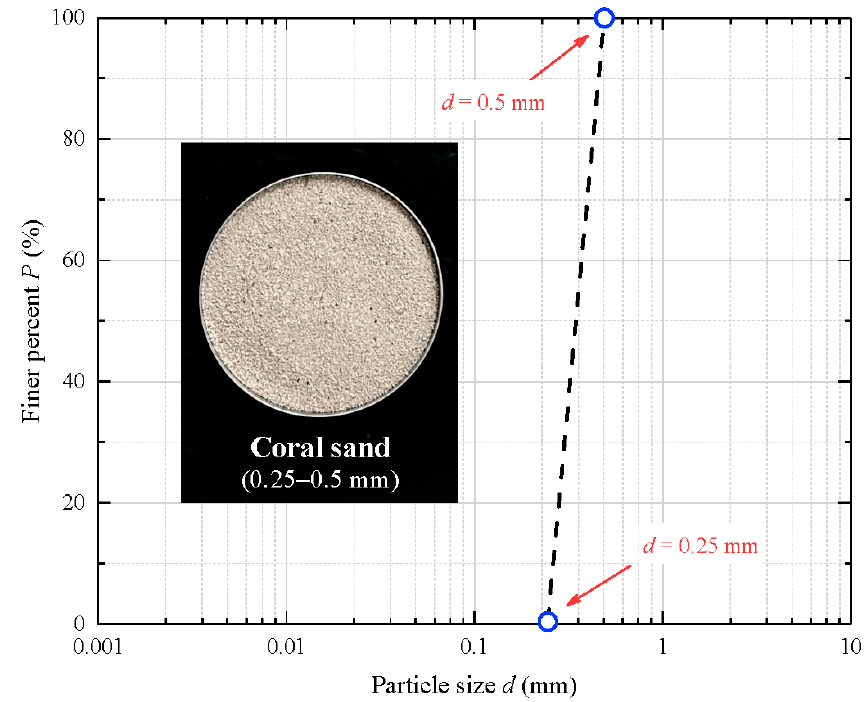
Figure 1. Particle distribution curve of coral sand. Table 3. Physical parameters of coral sand.